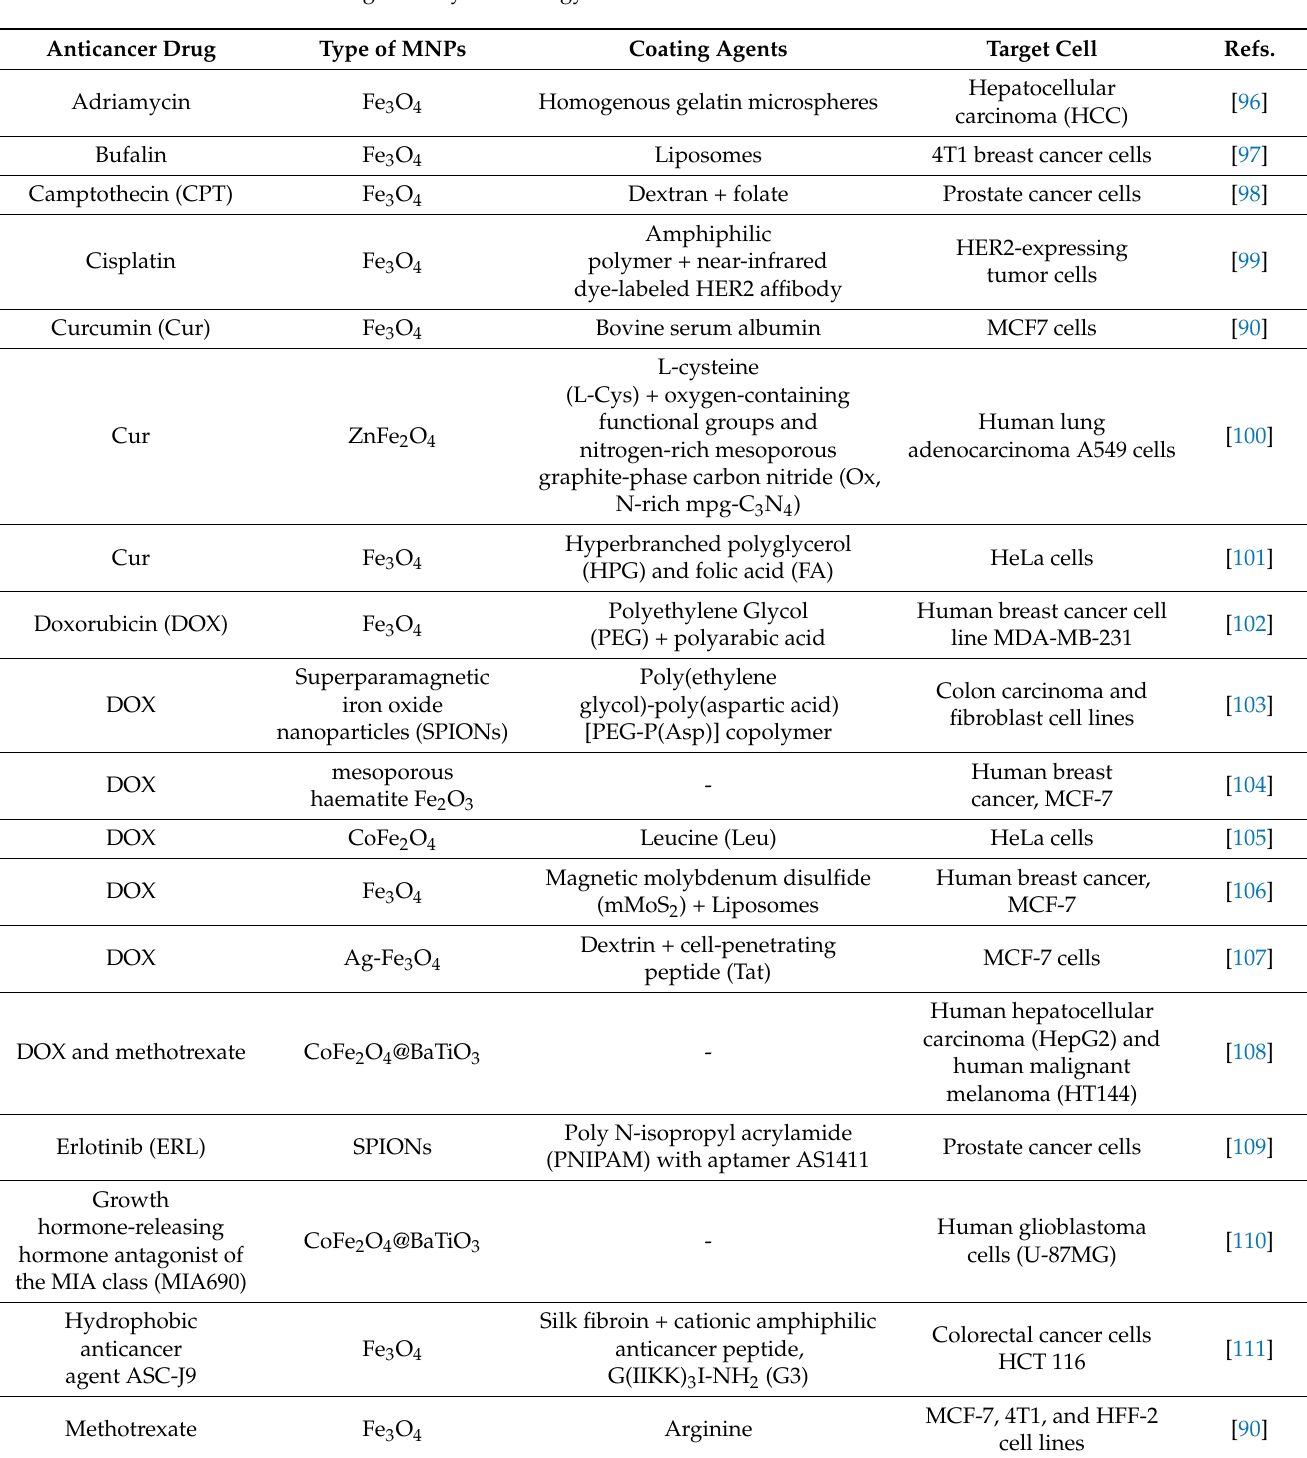
Table 2. The diversity of magnetic nanoparticle cores and shells modification agents for targeted drug delivery in